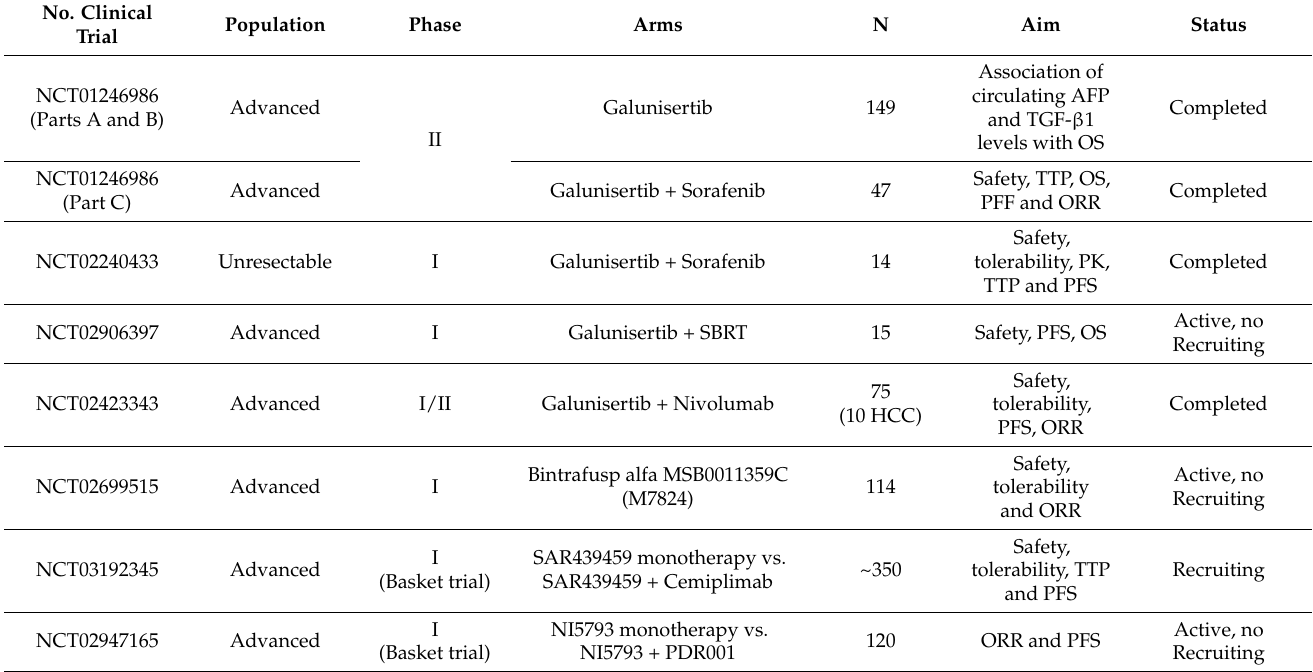
Table 3. Clinical trials evaluating TGF- β inhibitors in advanced